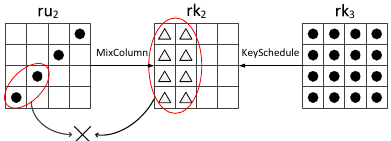
Figure 4: Key-dependent sieve technique based on the key-schedule algorithm of